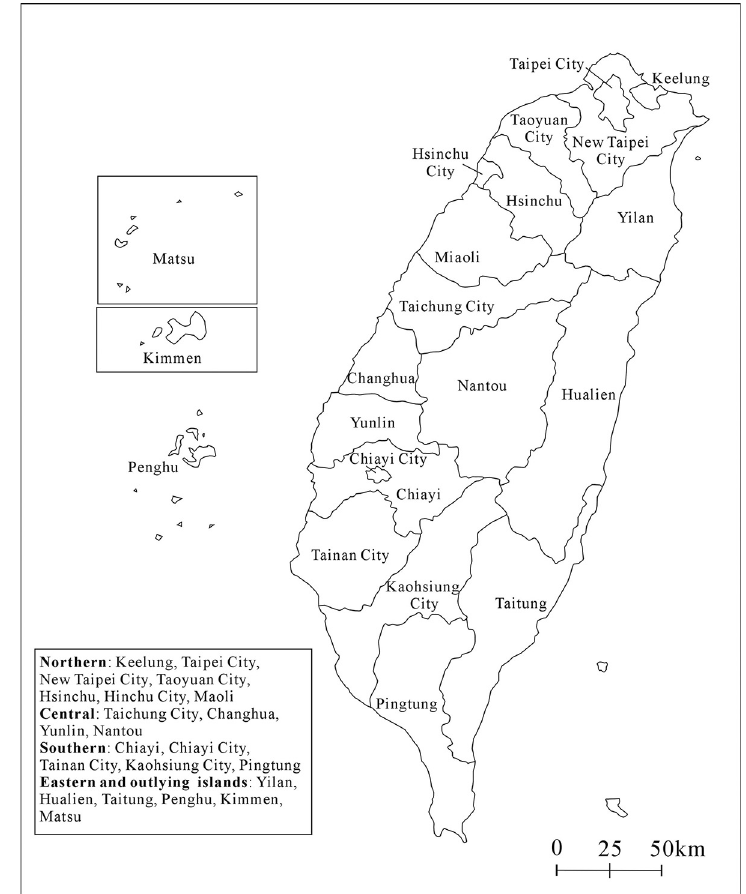
Figure 1. Map of Taiwan and the four regions